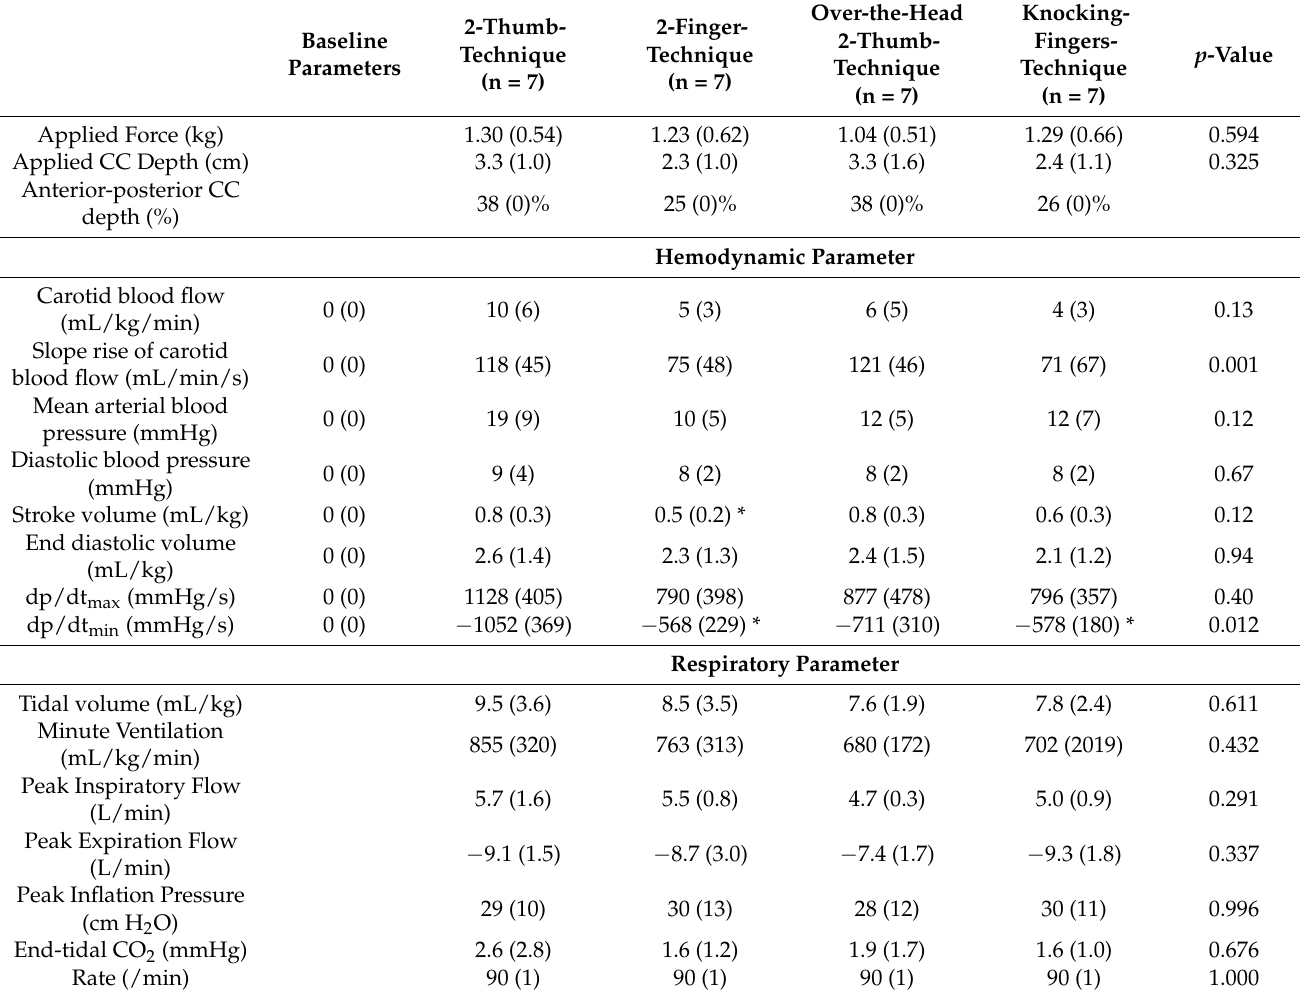
Table 1. Force, Depth, Hemodynamic, and Respiratory parameters during chest